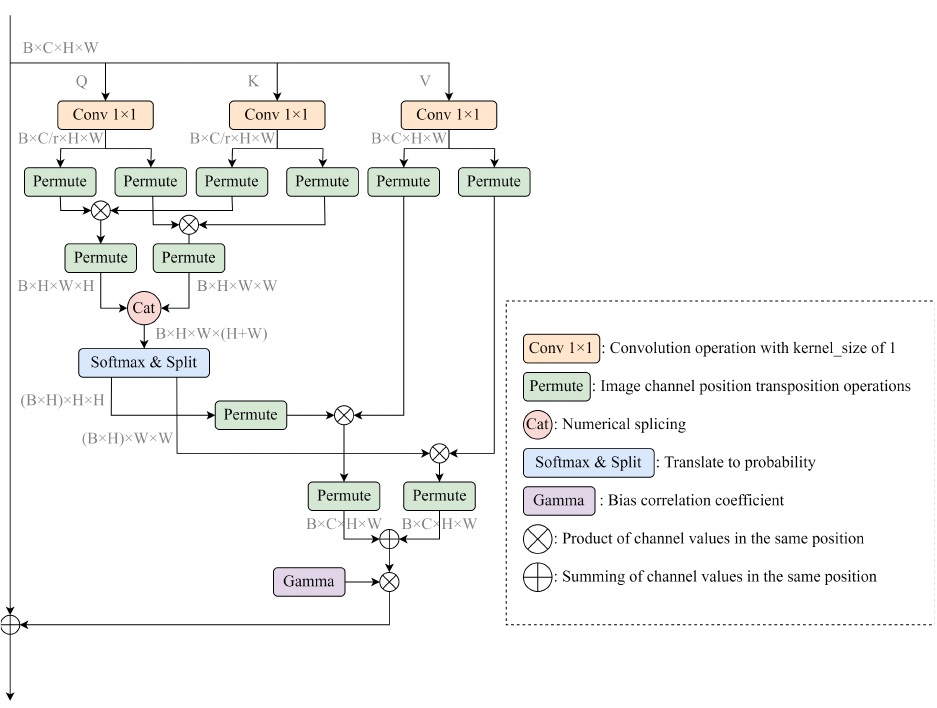
Figure 6. A permutation self-attentive mechanism is utilized to process both channel and spatial feature